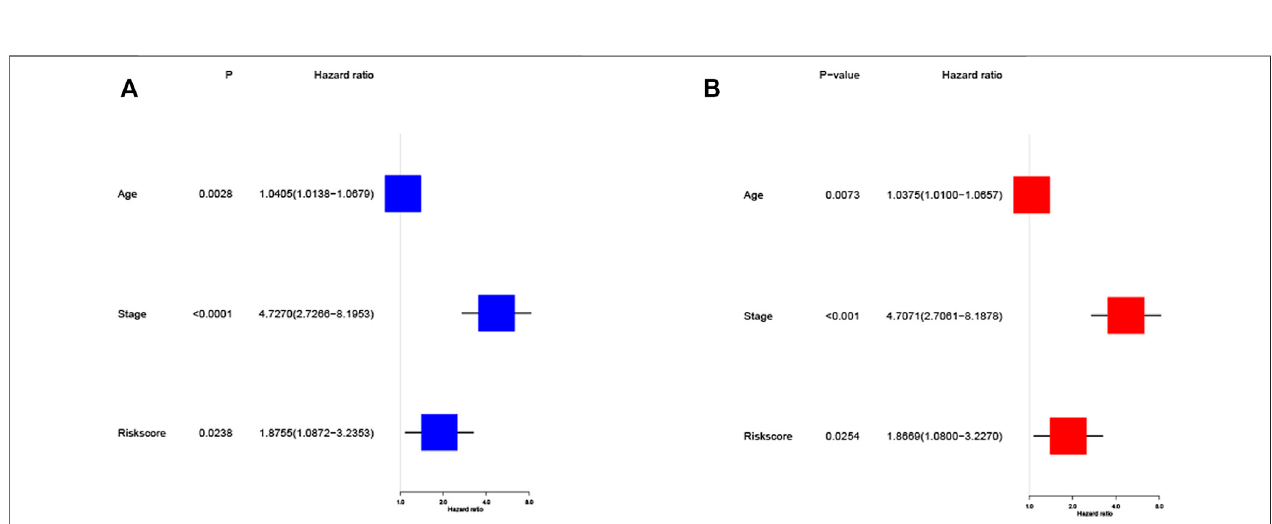
FIGURE 5 | Cox regression analysis of the risk score in training cohort. (A) Univariate regression analysis of the risk score in training cohort. (B) Multivariate regression analysis of the risk score in training cohort. (Stage: FIGO stage, I and II vs. III and IV).